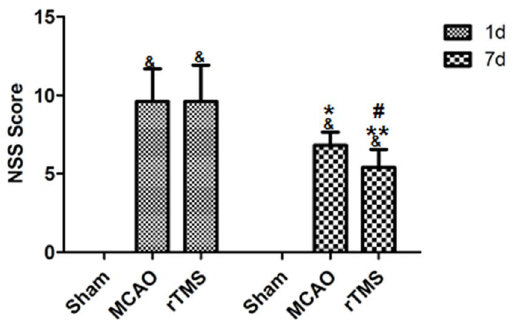
Figure 3. Neurobehavioral function was improved by rTMS after cerebral ischemia. NSSs were improved in MCAO rats treated with rTMS as compared with other groups. Data are presented as mean 6 SD. & P , 0.001 versus Sham group. * P=0.005 for MCAO group between day 7 and day 1. ** P , 0.001 for rTMS group between day 7 and day 1. # P=0.019 between rTMS group and MCAO group 7 days after surgery.